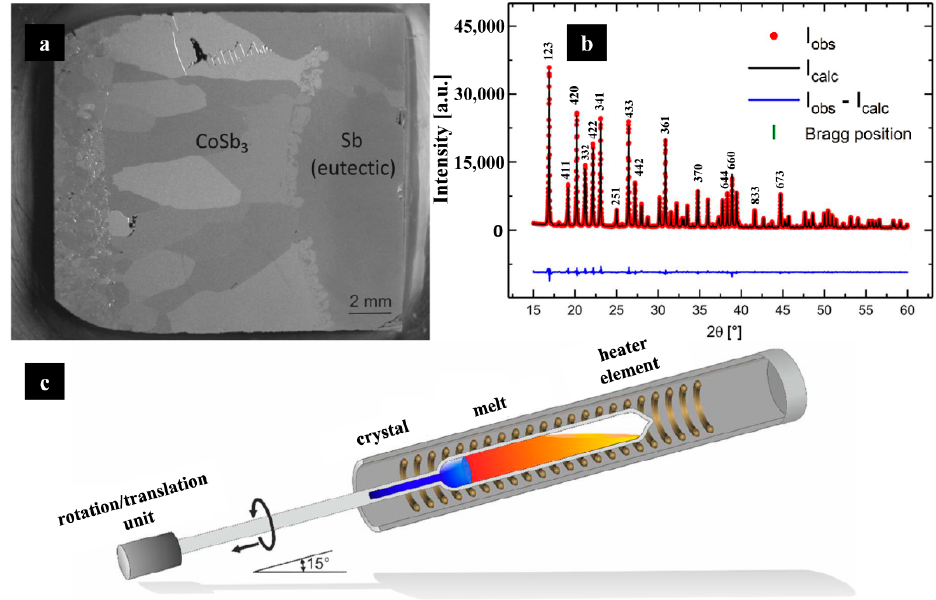
Figure 2. ( a ) Optical micrograph of the lapped surface of CoSb 3 ingot grown by the Inclined Rotary Bridgman method; ( b ) observed and calculated X − ray powder diffraction patterns of CoSb 3 ; ( c ) schematic of the apparatus used for the inclined Rotary Bridgman experiments [28].